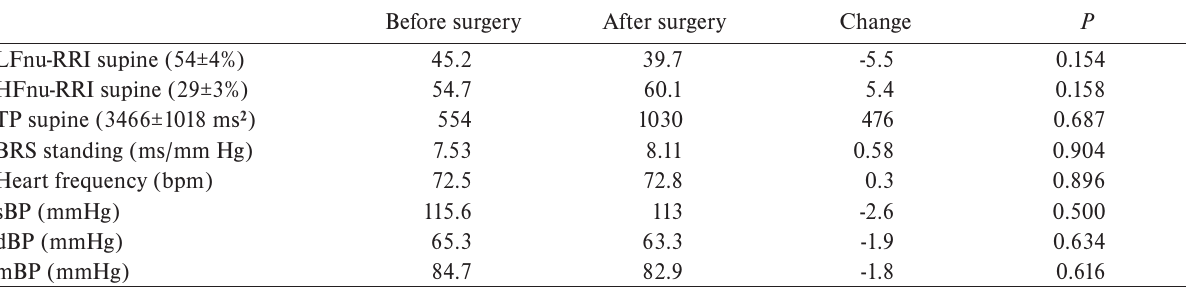
Table 2. Autonomic nervous system parameters. Before